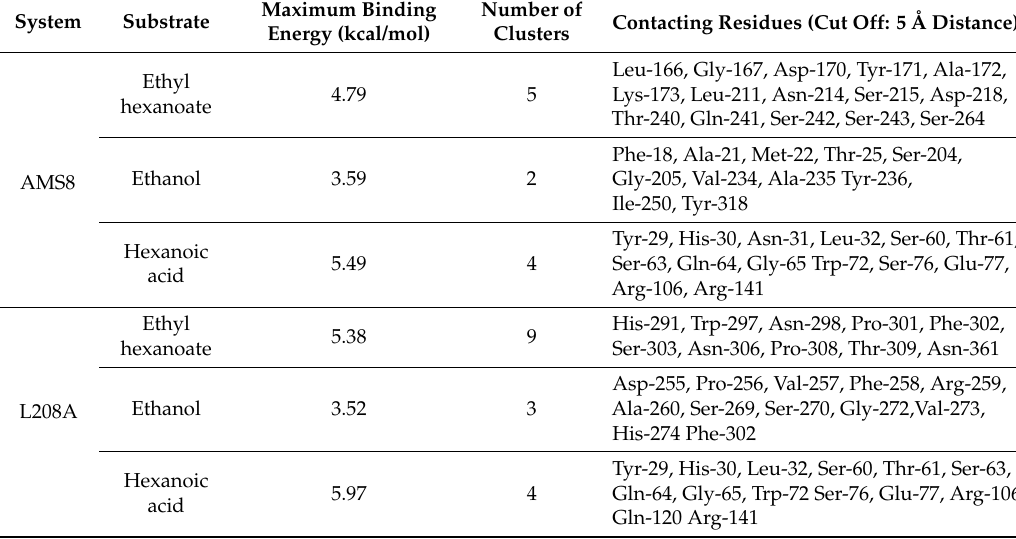
Table 1. A comparison of binding energy and number of clusters accumulated from all productive poses between AMS8 lipase and mutant L208A.